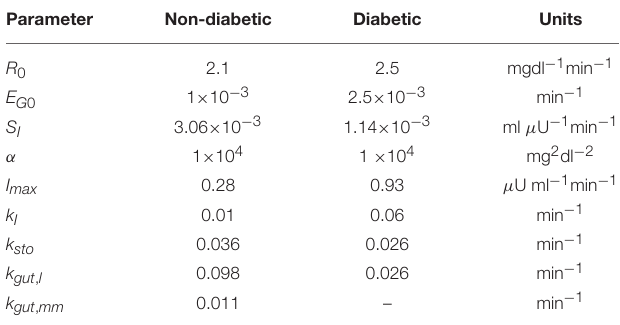
TABLE 1 | Parameters corresponding to the non-diabetic and diabetic CGM time series.